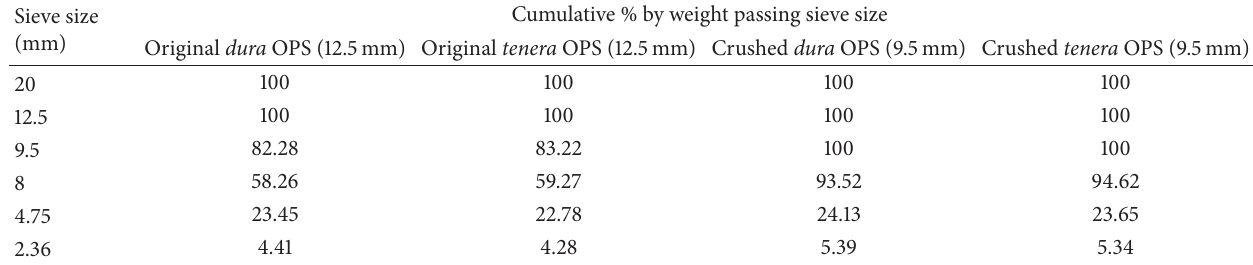
Table 3: Grading of OPS